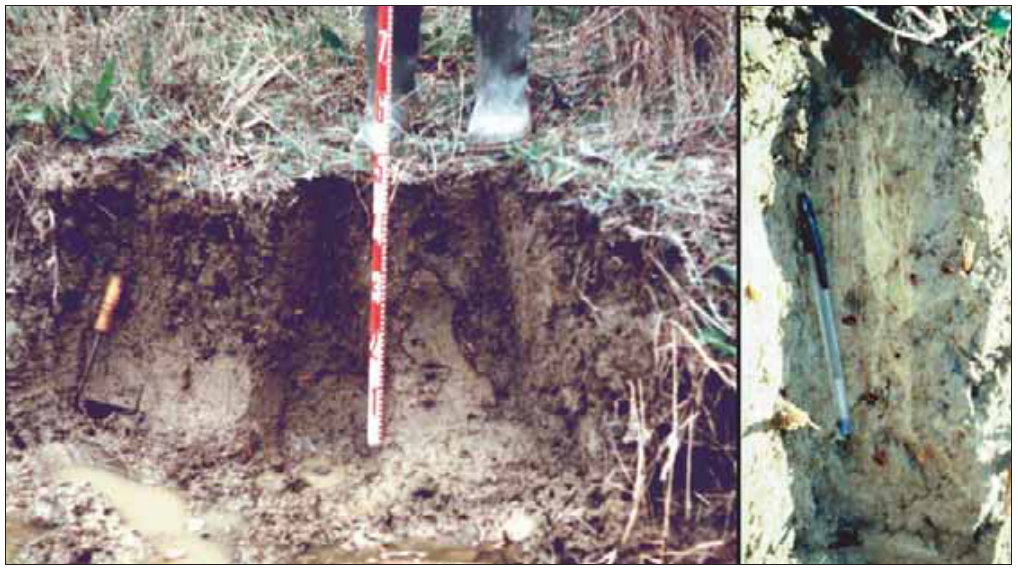
Fig. 5. Pictures of the sand dikes observed on the cutbanks of an abandoned channel at Le Casette 2